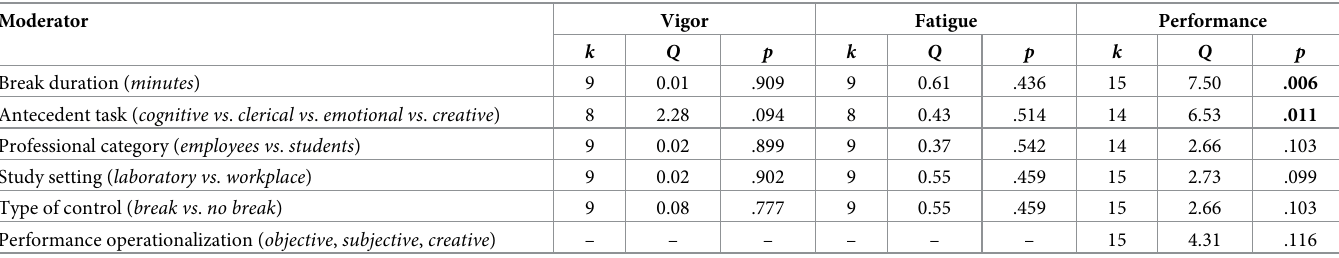
Table 4. Test of significance for each presumed moderator.